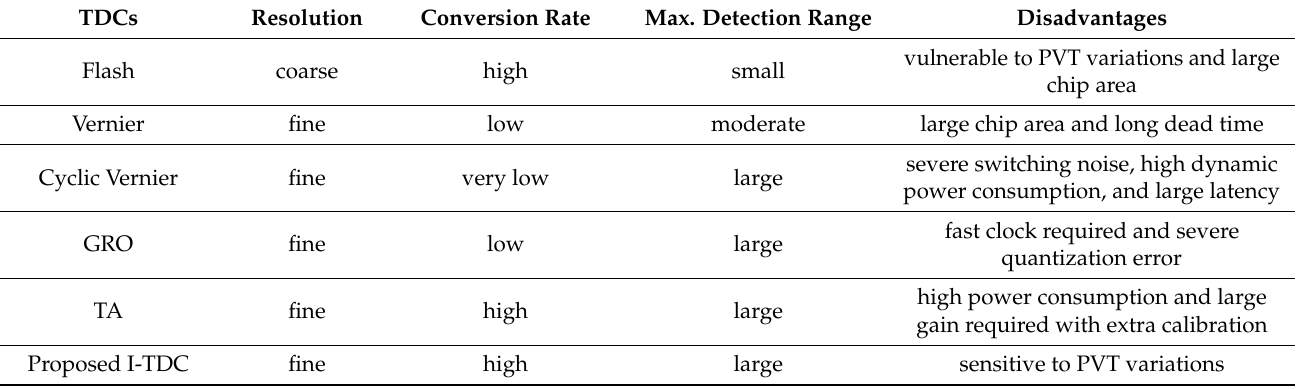
Table 1. Comparison of the proposed I-TDC with other